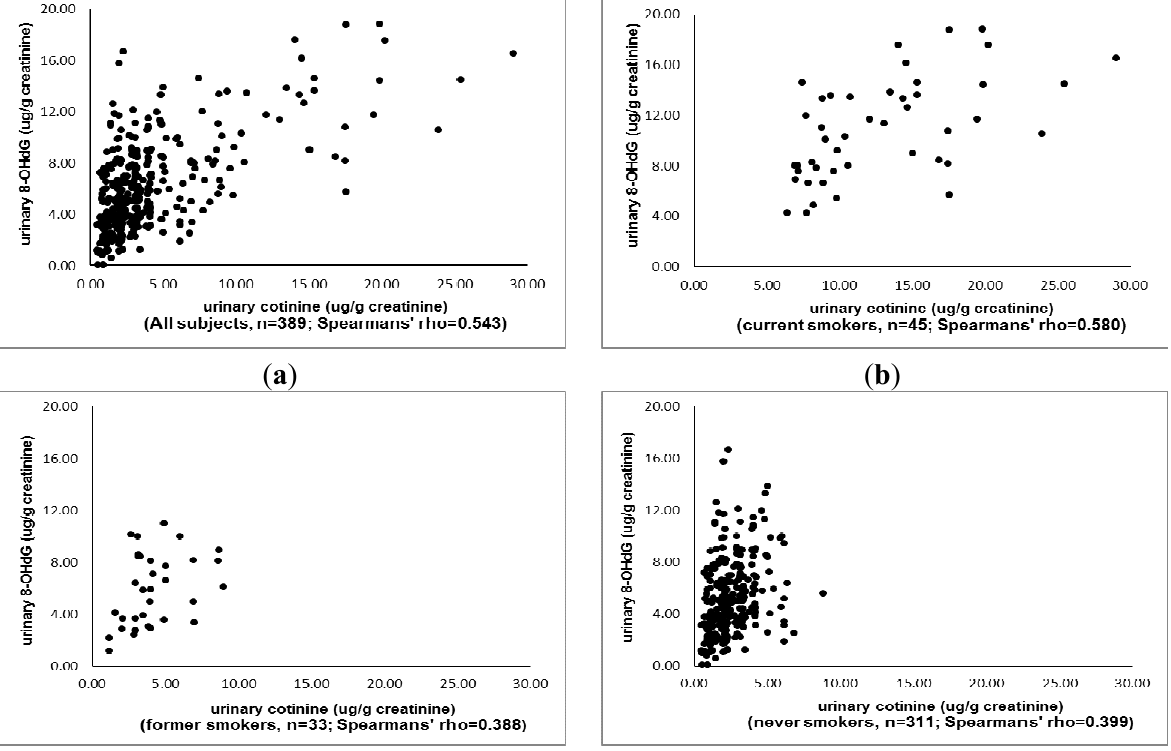
Figure 1. The scatter plots and Spearmans’ rho between urinary cotinine and 8-OHdG by smoking status. ( a ) for all subjects; ( b ) for current smokers; ( c ) for former smokers and ( d ) for never